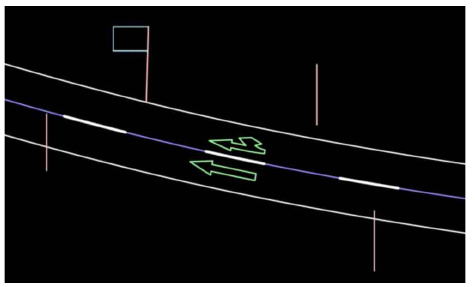
Figure 4. Example of structural semantic element